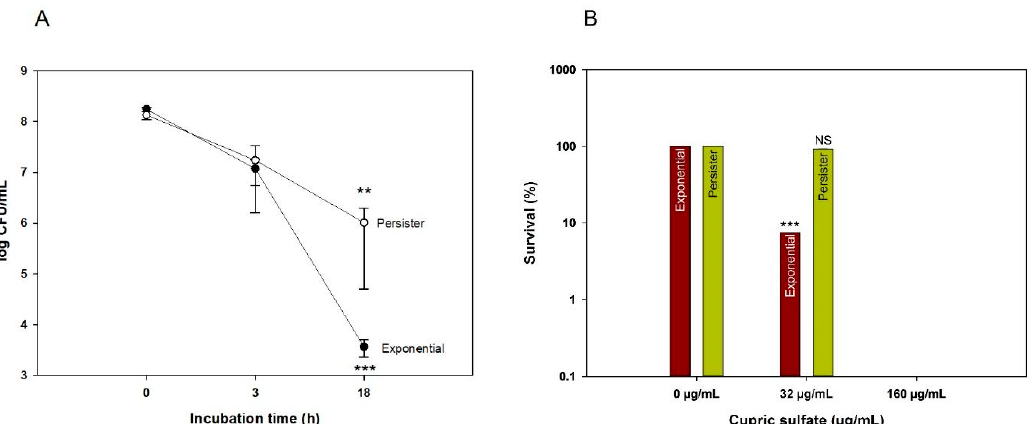
Figure 1. Exponential and persister cell viability with copper in rich medium and in buffer. ( A ) Both exponential and persister cells were incubated for 18 h with copper (960 µg/mL cupric sulfate, 1 × minimum inhibitory concentration (MIC)) in lysogeny broth (LB). Error bars indicate standard deviation. ( B ) Survival under copper stress in 0.85% NaCl buffer after 1 h. Since we could not recover viable cells after incubating with 1 × MIC (160 µg/mL), a 1 / 5 concentration was used in buffer (32 µg/mL). Relative survival obtained after copper was added to the bacterial suspension in NaCl buffer. The symbols *** ( p < 0.001) and ** ( p < 0.05) indicate significant differences. NS indicates that non-significant difference was found.